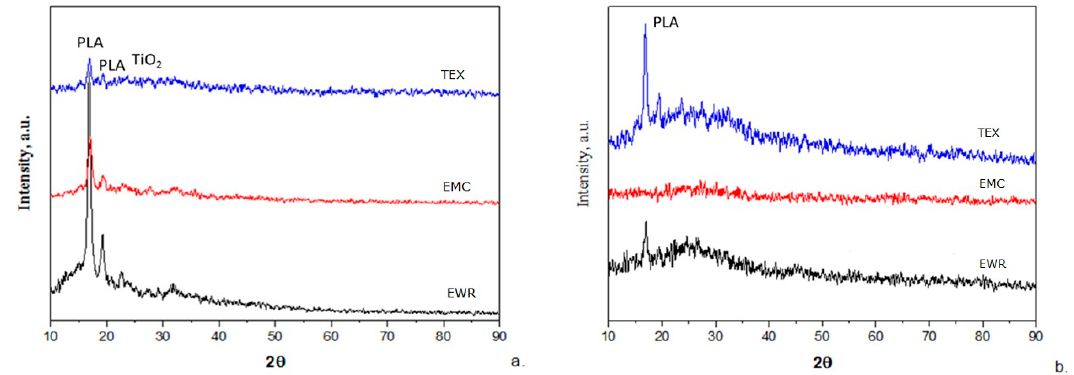
Figure 8. X-ray diffraction (XRD) patterns of membranes: ( a ) before photocatalysis; ( b ) after photocatalysis.